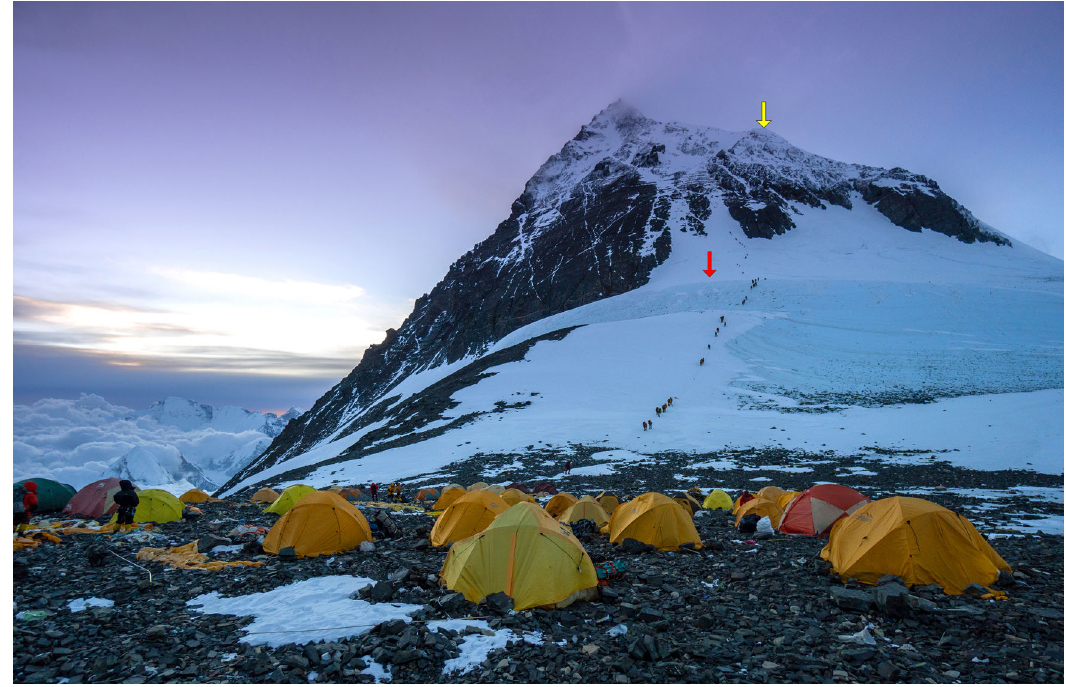
Fig. 1 South Col Glacier. South Col Glacier ice core (8220 m) (red arrow) and Balcony AWS (8430 m) locations (yellow arrow) with South Col camp in the foreground - looking North. The South Col AWS is 500 m South of the camp (outside this picture). Picture by Mariusz